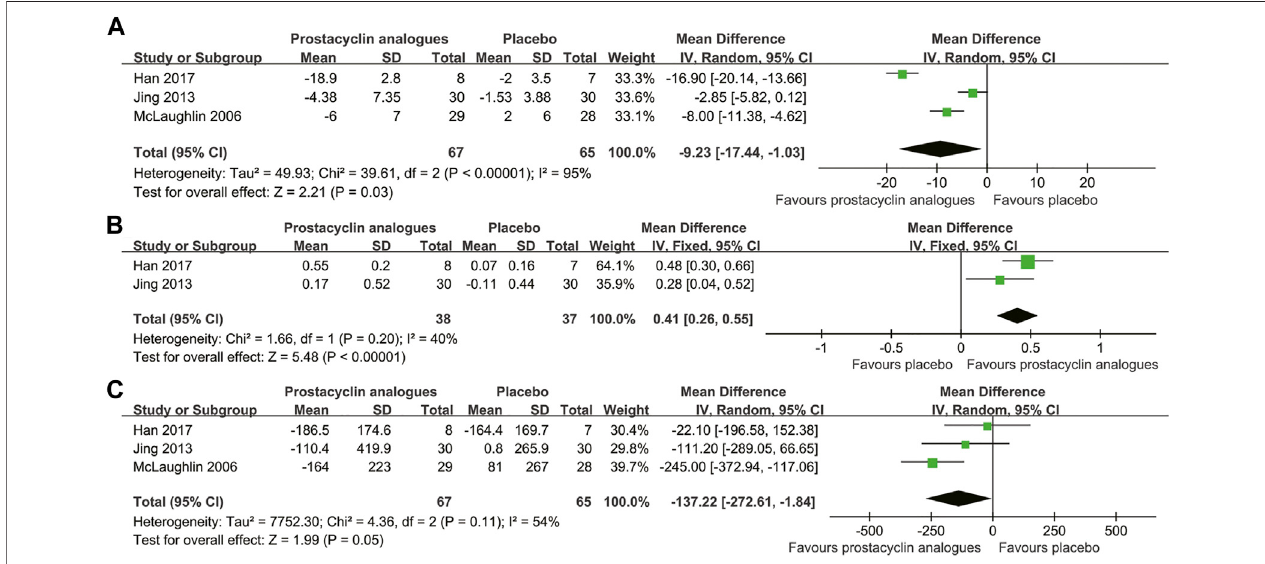
FIGURE3| Forestplotcomparingprostacyclinanaloggroupwithcontrolgroupformeanpulmonaryarterypressure (A) ,cardiacindex (B) ,andpulmonaryvascular resistance (C) .